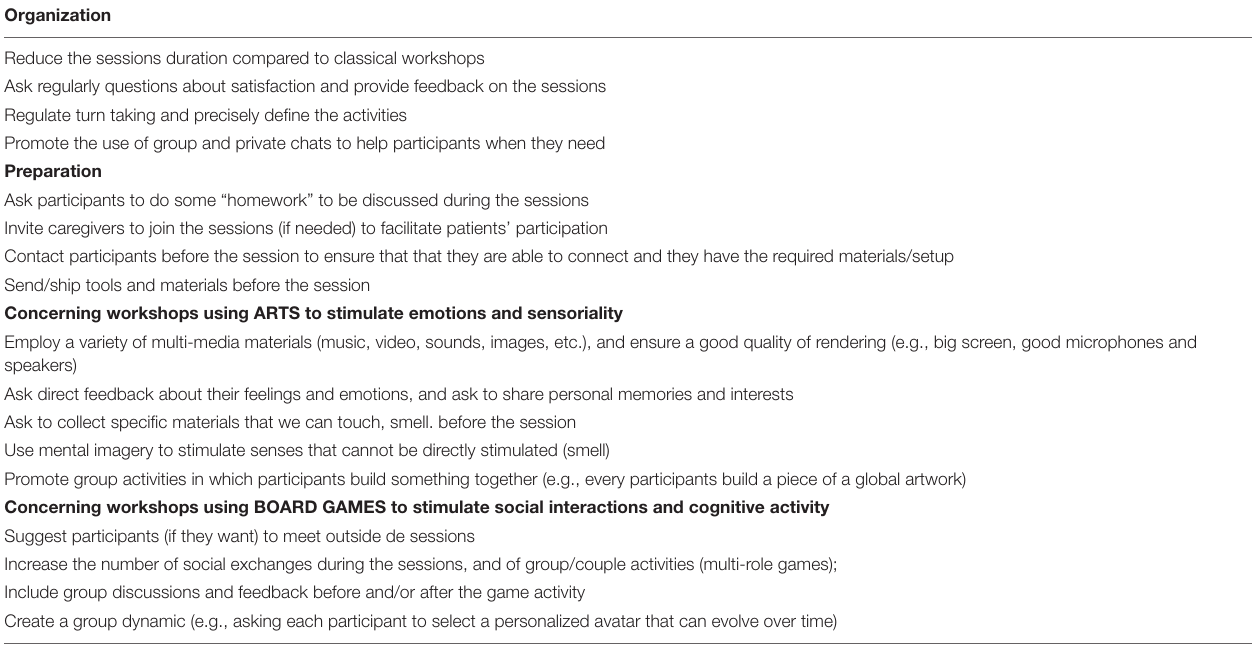
TABLE 4 | Recommendations on how to facilitate the activity of the participants connected remotely in remote/hybrid